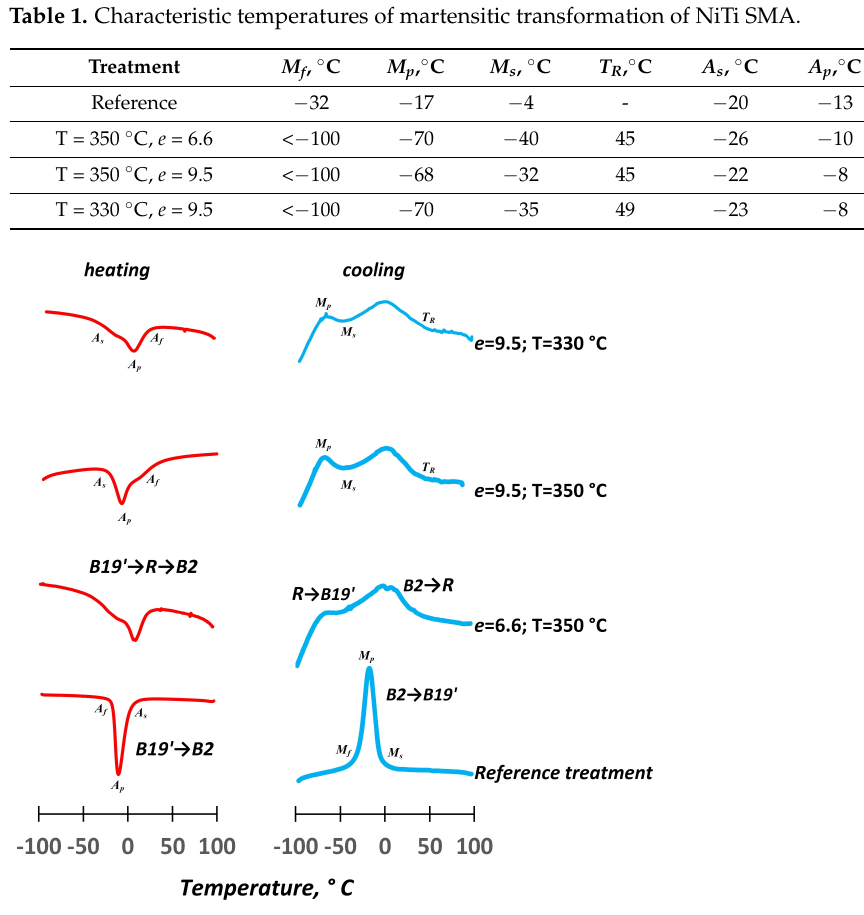
Figure 5. DSC curves of NiTi at room temperature after various treatments. Table 1. Characteristic temperatures of martensitic transformation of NiTi